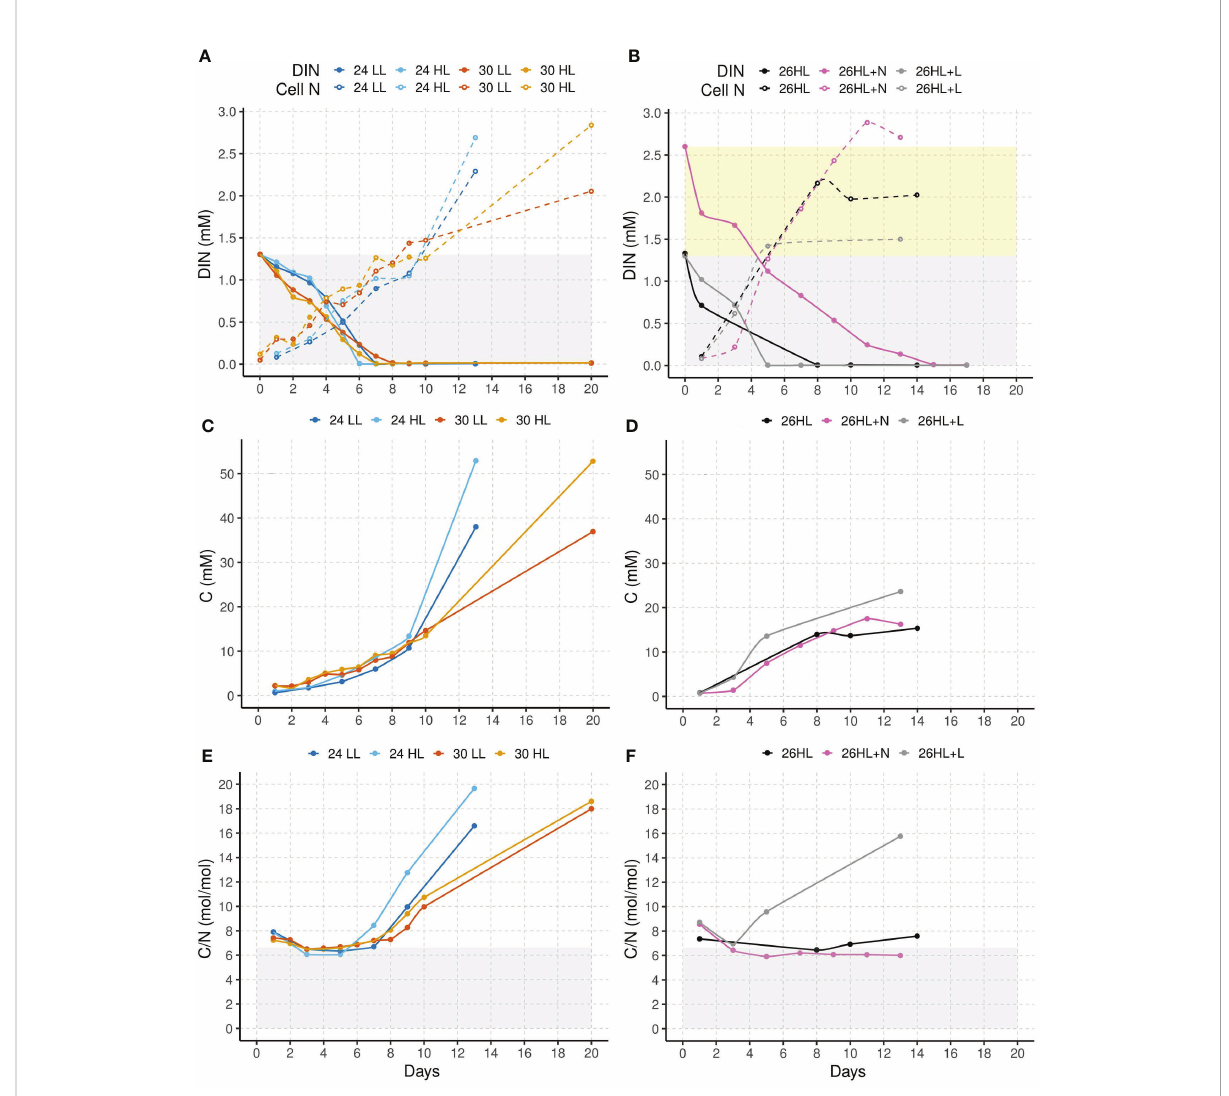
FIGURE 3 Nitrogen and carbon dynamics in batch-experiments by P. wilhelmii , grown in ORWW sampled in spring (left) and summer (right). Dissolved inorganic nitrogen and cellular N (A, B) , cellular C (C, D) , and cellular C/N ratio (E, F)